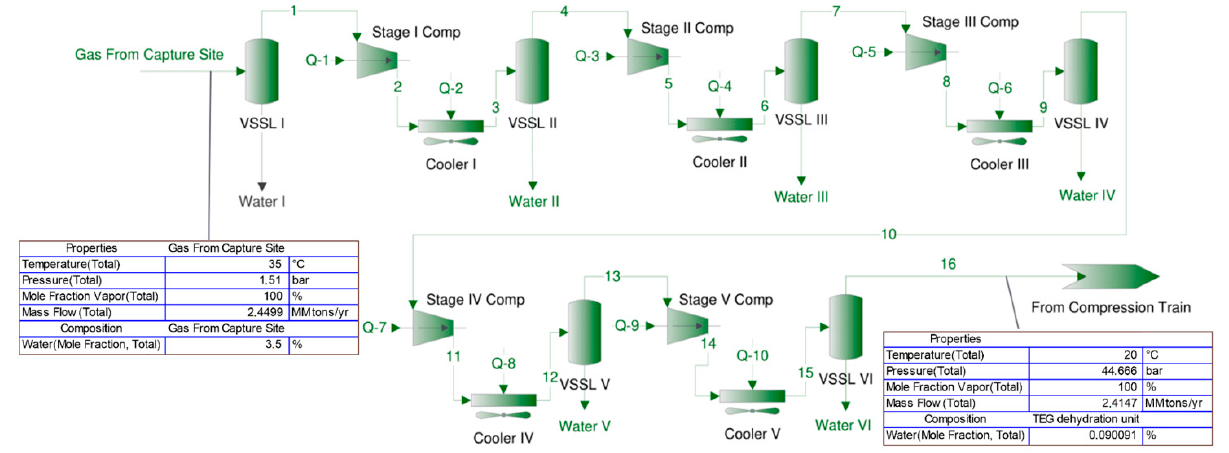
Figure 3. CO 2 compression train (first part of the plant).